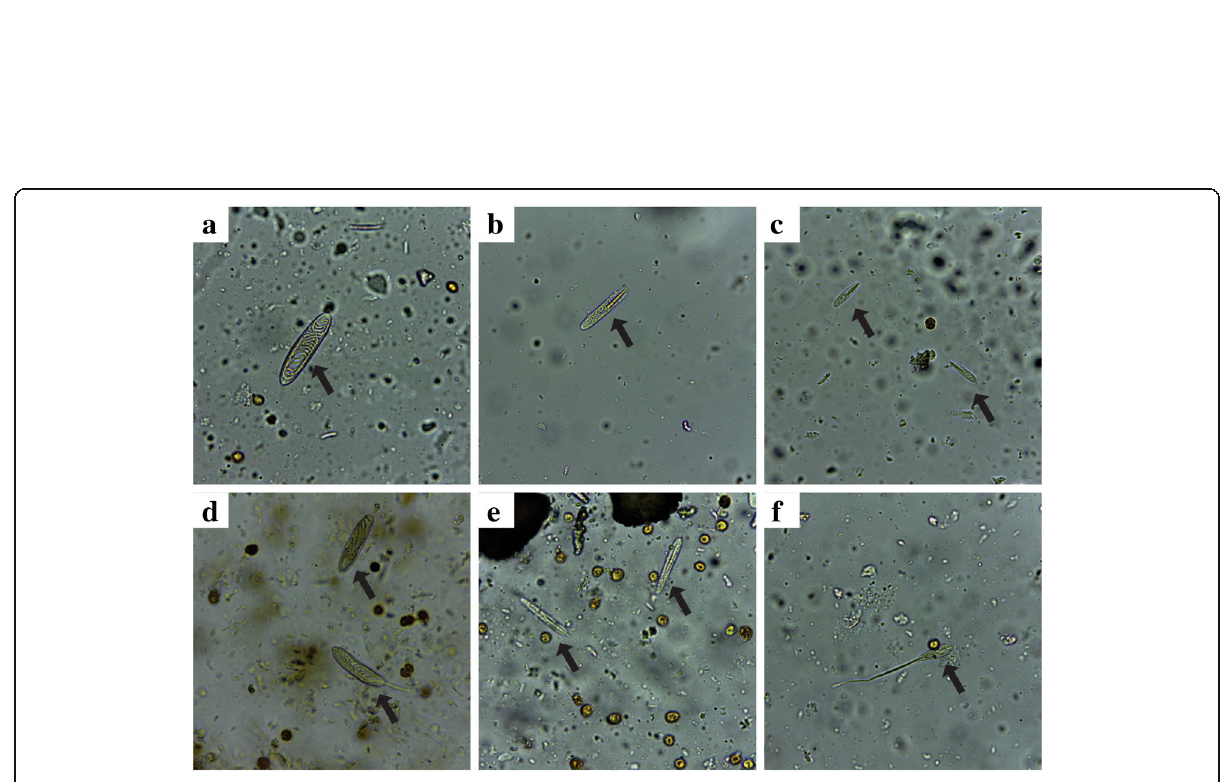
Fig. 10 Light micrographs showing nematocyst found in soft tissues of the corals. a Holotrich of P. strigosa , ( b ) large p-rhabdoid of P. strigosa , ( c ) small p-rhabdoid of P. strigosa , ( d ) holotrich of P. astreoides , ( e ) p-rhabdoid of S. siderea , and ( f ) holotrich of S. sidereal . Magnification